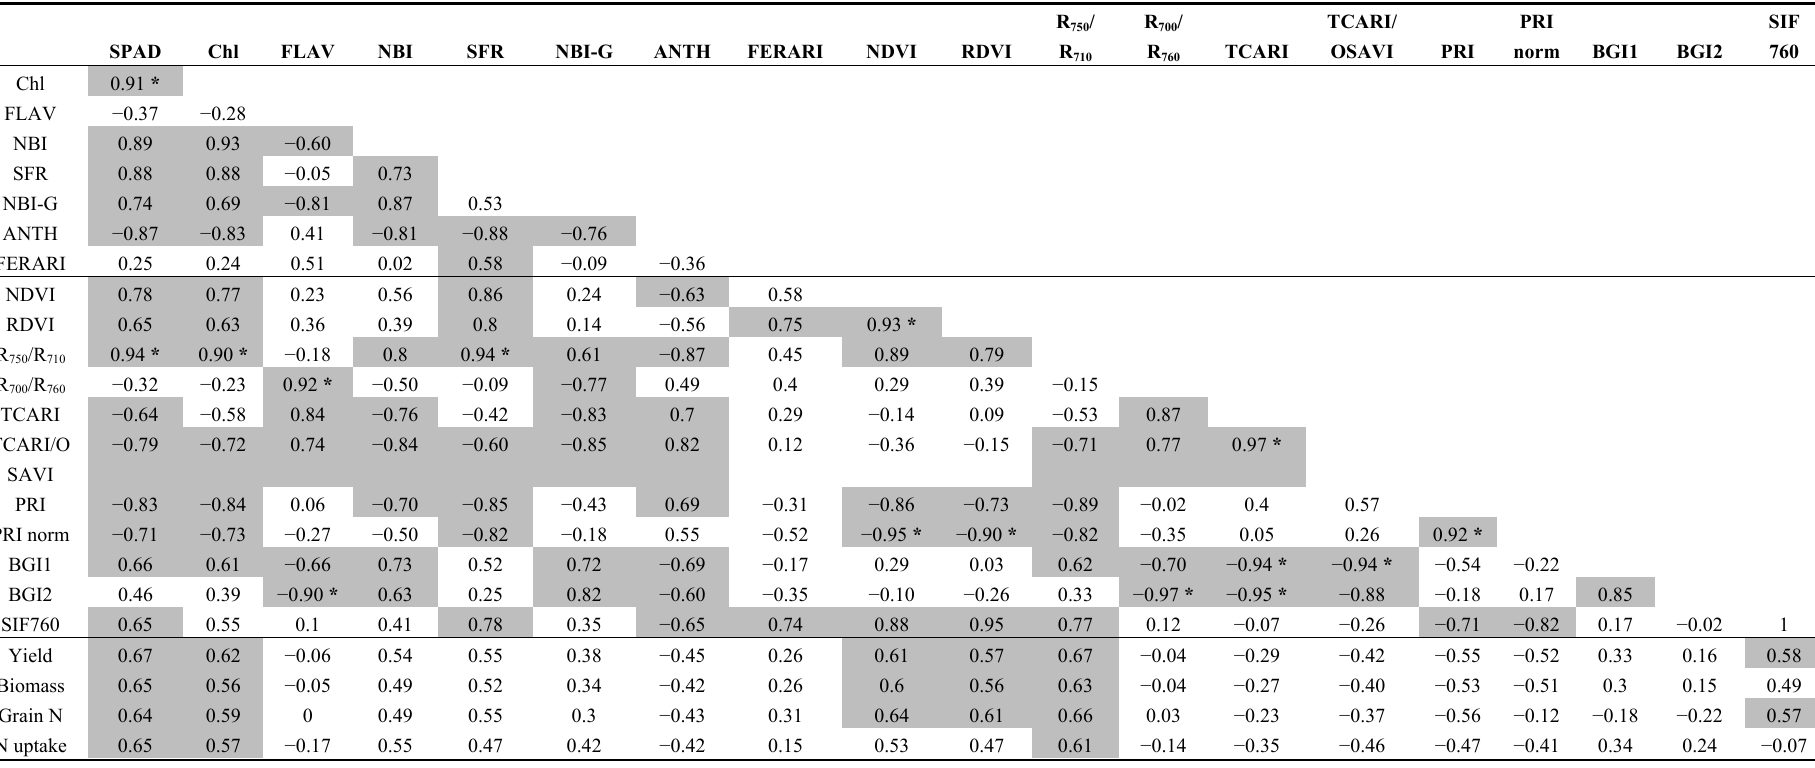
Correlations obtained with p < 0.05 or better between different functional groups of the indices are shaded and marked as * when p <